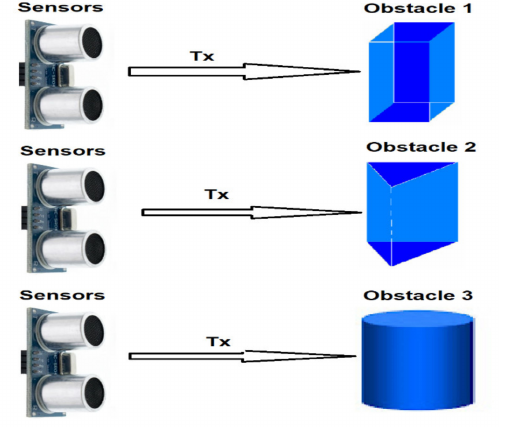
Figure 18. Obstacles of various